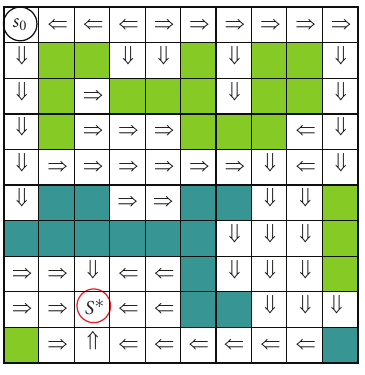
Figure 1: An illustrative example of finding the shortest path in a grid